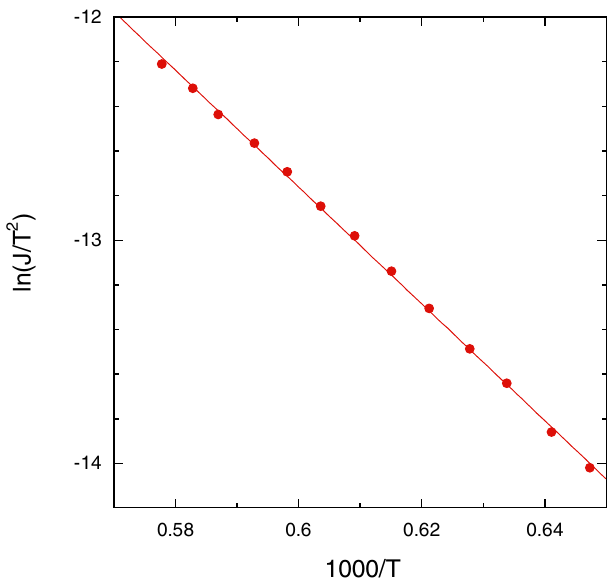
FIG. 6. (Color) Richardson plot for the CeB Temperature T is expressed in Kelvin and current density J in A = cm 2